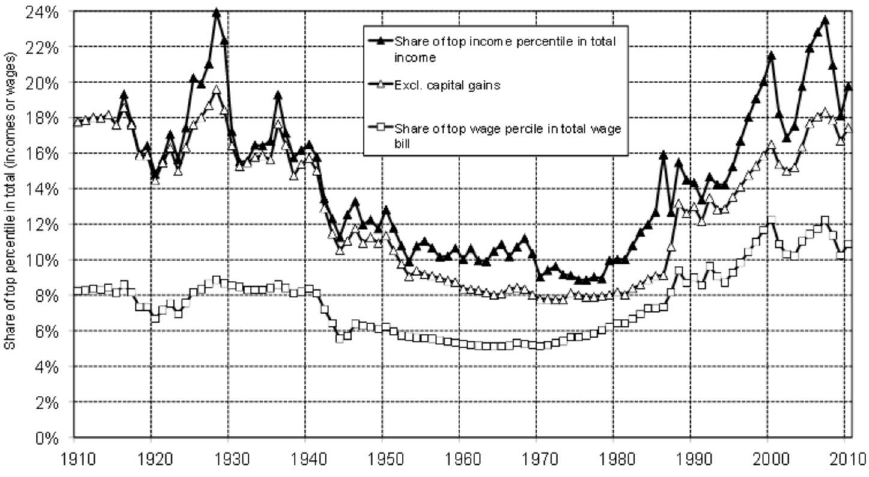
Source: based on T. Piketty, http://piketty.pse.ens.fr/files/capital21c/en/pdf/F8.8.pdf, access